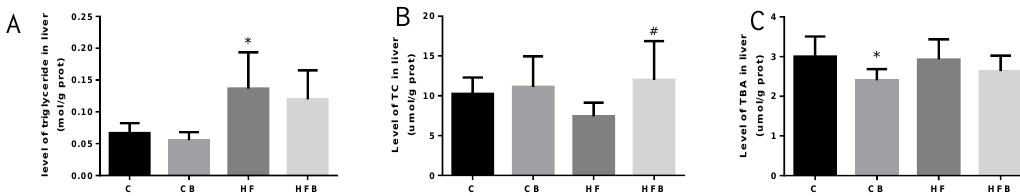
Figure 4. Effects of betaine and high-fat diet on hepatic metabolites in rats ( n = 8). * Significantly different from the C group ( p < 0.05). # Significantly different from the HF group ( p < 0.05). ( A ) Level of hepatic triglyceride. (BET, p = 0.303, FAT, p < 0.001, interaction, p = 0.836). ( B ) Level of hepatic total cholesterol (TC) (BET, p = 0.036, FAT, p = 0.436, interaction, p = 0.145). ( C ) Level of total bile acids (TBA) in the liver (BET, p = 0.006, FAT, p = 0.604, interaction, p = 0.314).